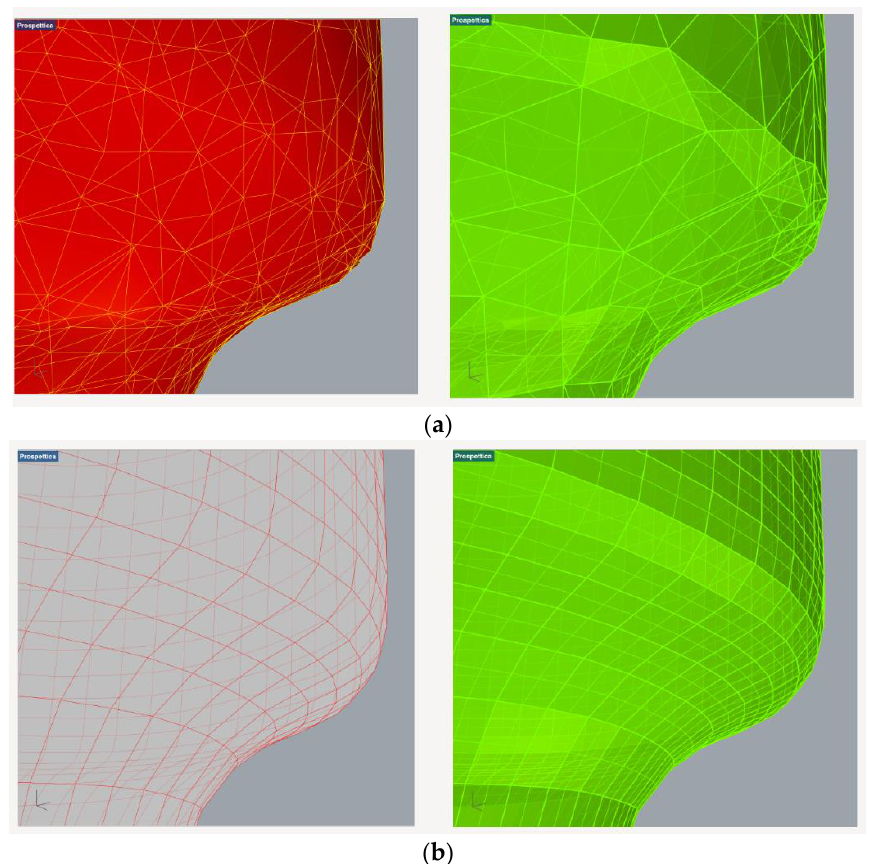
Figure 5. The comparison between a simplified triangular mesh and its corresponding NURBS ( a ) and the retopologised mesh with its corresponding NURBS ( b ). The meshes are represented in red (left side of the images) and the NURBS in green (right side of the images).